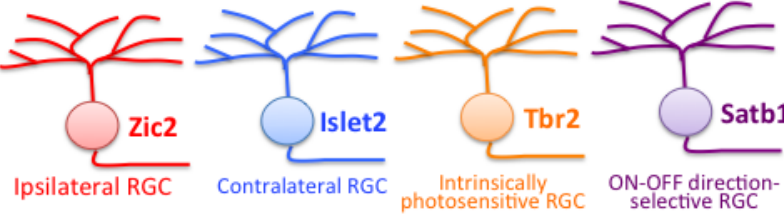
Figure 5. Examples of specific transcription factors that determine the identity of RGC subtypes or subclasses.